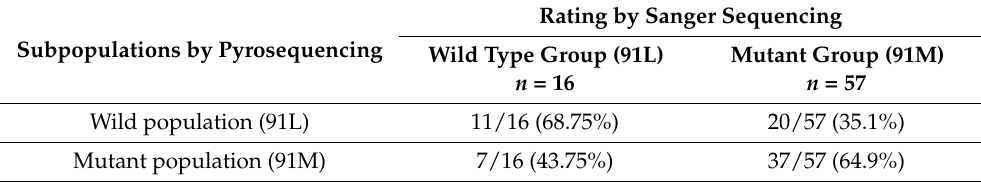
Table 3. Pyrosequencing result in mutants and